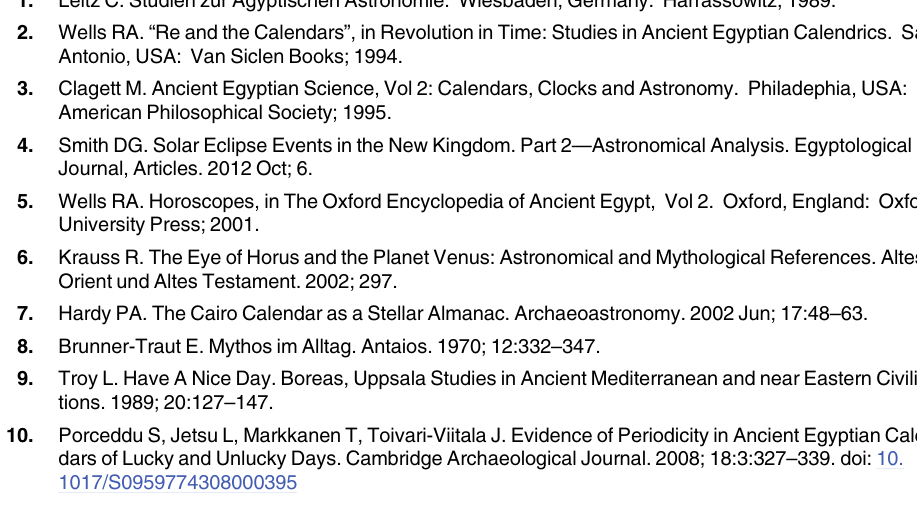
S1 Fig. Text of Cairo Calendar page rto VIII. Inside our superimposed rectangle is the hier- atic writing for the word Horus . Reprinted from Leitz [12] under a CC BY license, with permis- sion from Harrassowitz Verlag, original copyright [1994]. S1 Table. Analysis results for all SWs. Day ( D ), month ( M ) of lucky ( g ), phase angle ( Θ ), direction of their R vector ( Θ points, their phase ( ϕ i i − Θ Δ with Eq (11) for P = 2.85 days and Eq (12) for PM = 29.6 days. The binomial distribu- i R A , n , q for Q . Note that the parameters are given in the order of increas- tion parameters are n 1 2 B B ing ΔΘ , n and n . All values mentioned in text are marked in bold. We also make available the i 1 2 code of a Python 3.0 program tableS1.py which can be downloaded on Dryad (http://dx.doi. org/10.5061/dryad.tj4qg). This program can be used to reproduce and replicate all analysis results given in S1